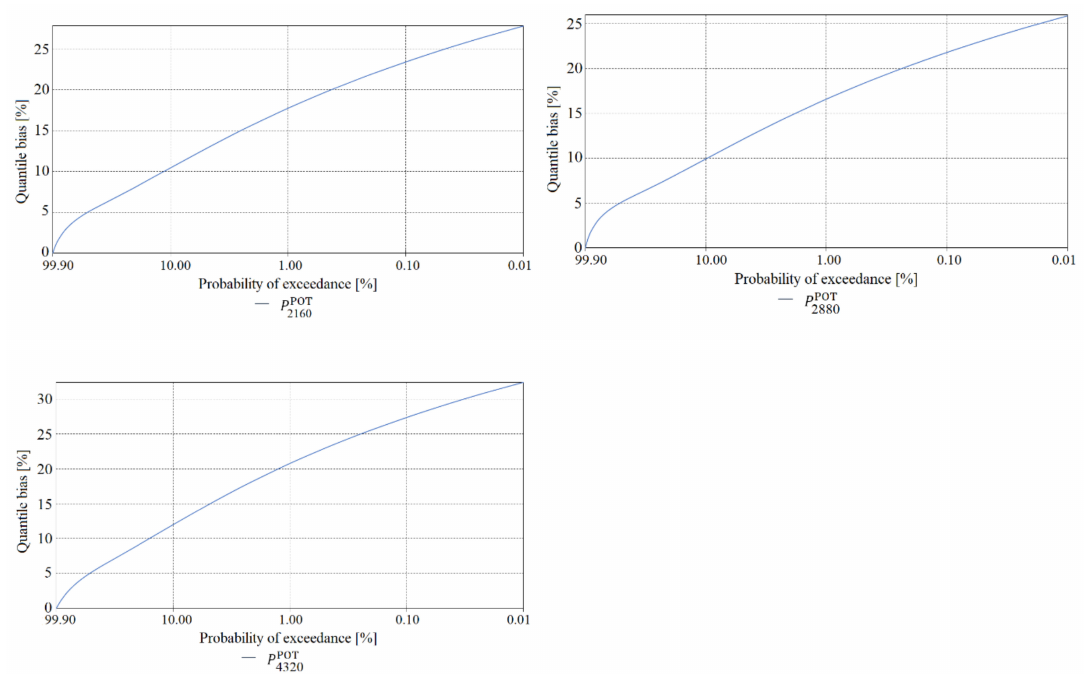
Figure 16. Comparison of estimated values of quantile error resulting from the randomness of the sample of maximum precipitations computed using the PMAXTP model for the random variable P POT τ with durations τ = {2160, 2880, 4320} min, for the Bialystok meteorological station.